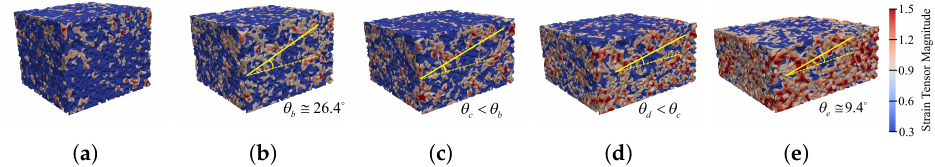
Figure 14. The micro-strain contour evolution during the compaction process of specimen S 6 , ( a ) (cid:101) 3 = 0.1, ( b ) (cid:101) 3 = 0.2, ( c ) (cid:101) 3 = 0.3, ( d ) (cid:101) 3 = 0.4, ( e ) (cid:101) 3 = 0.5.